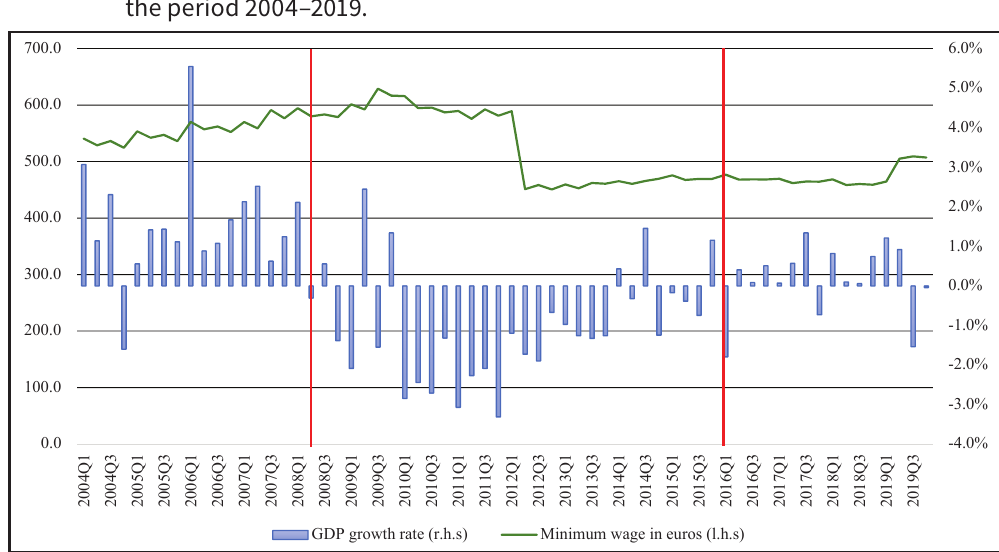
GDP growth rate (r.h.s) Minimum wage in euros (l.h.s) Data source : Hellenic Statistical Authority, Ministry of